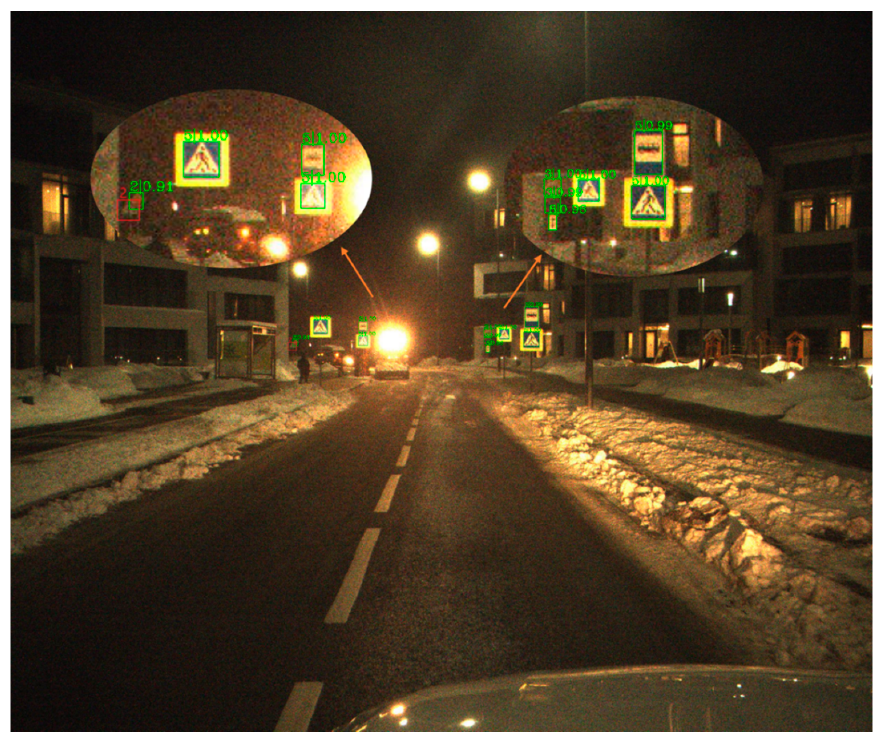
Figure 6. The visualization of the Libra-RCNN result on ITSDB detection. Green square represents detection result of the model, and red square represents target missed or wrong detection results.